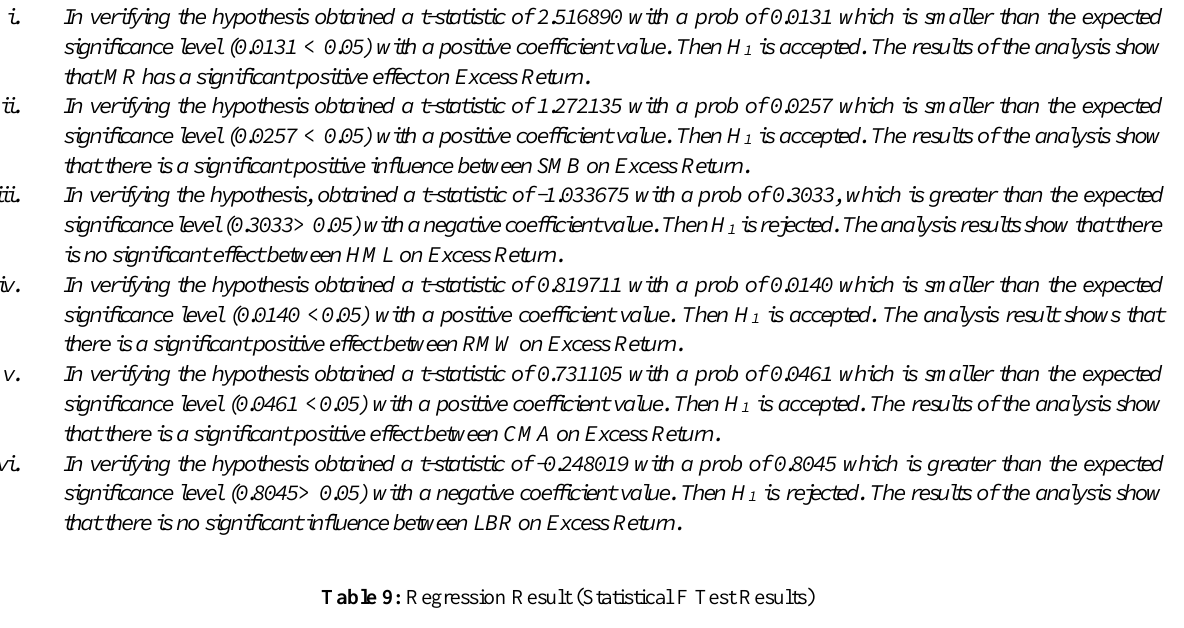
Table 9: Regression Result (Statistical F Test